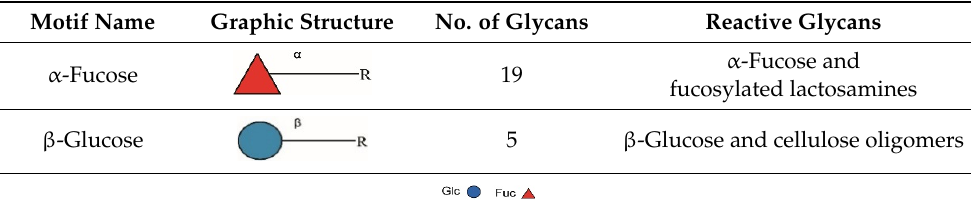
Table 2. MotifFinder Identified Primary Binding Motifs. Results from the glycan array binding ex- periment using VT68.2 were analyzed by MotifFinder to identify primary terminal VT68.2-binding